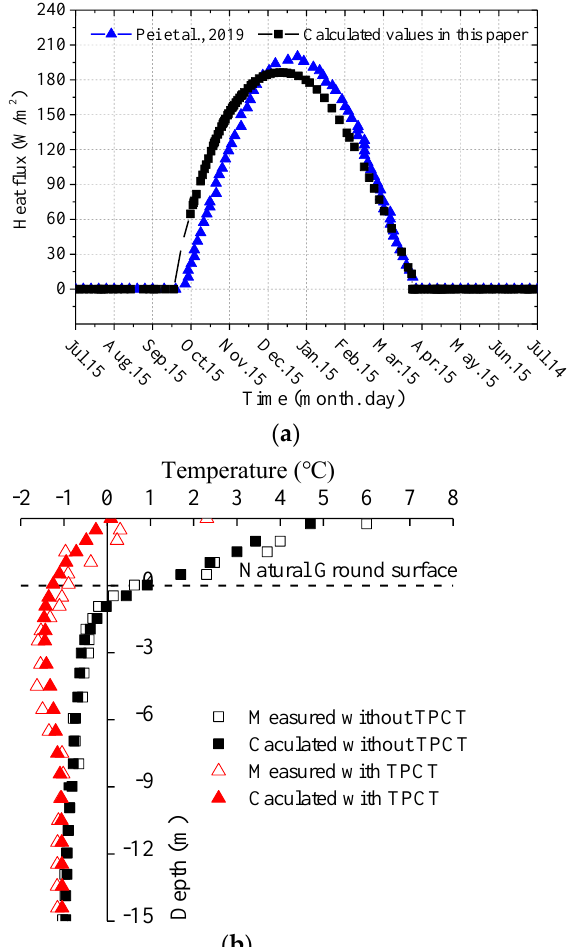
Figure 4. Validation of the numerical calculation results: ( a ) heat flux of the TPCT (fifth year) [25]; ( b ) geotemperatures at the of subgrade center (15 October, fifth year).